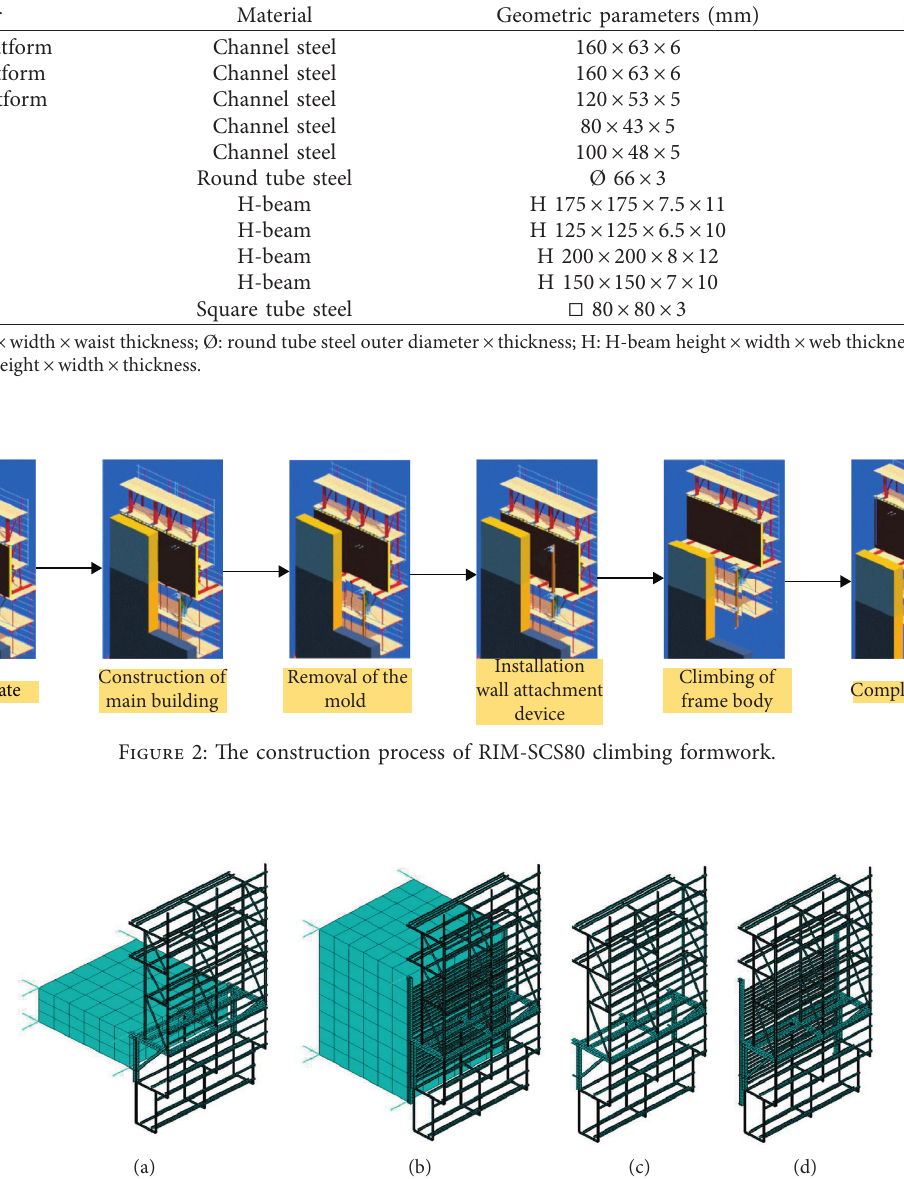
Figure 3: Finite element models. (a) COC model, (b) CLC model, (c) CO model, and (d) CL model.